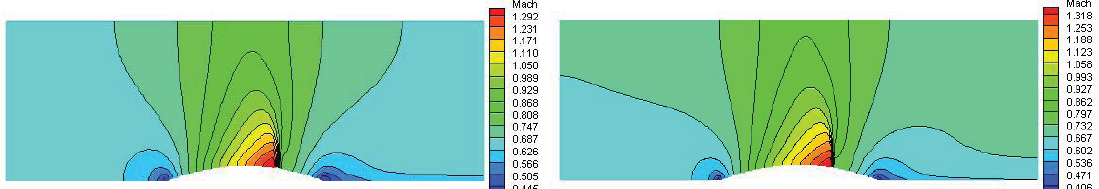
Figure 7: Inviscid compressible flow in the G AMM channel: Mach number isolines at M 1 = 0 . 675 – WLSQR scheme by J. Fürst [5], IBC A , a structured non-orthogonal grid with 150 × 50 cells [ M max = 1 . 29 (left)] and with 300 × 100 cells [ M max = 1 . 32 (right)].